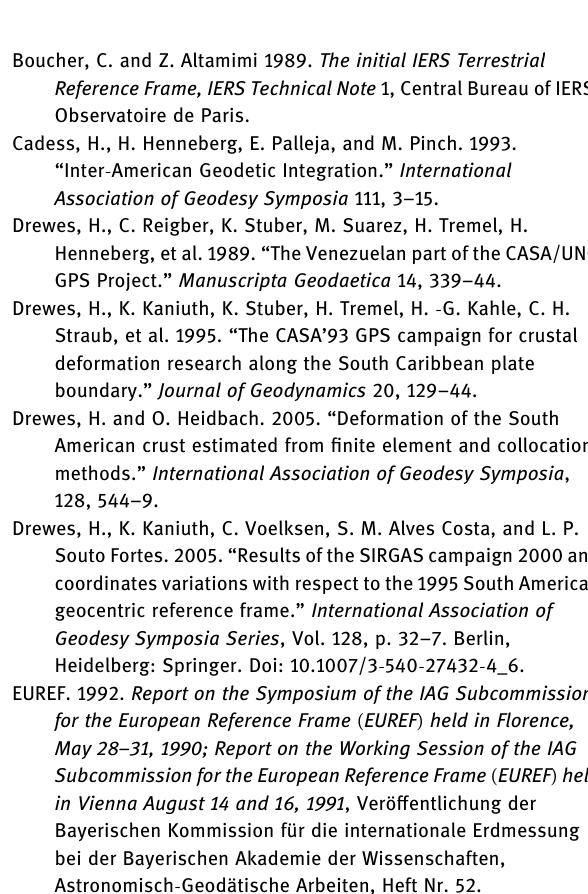
Figure 9: Changing surface deformation from VEMOS2009, 2015, and 2017 ( Sánchez and Drewes 2020 )